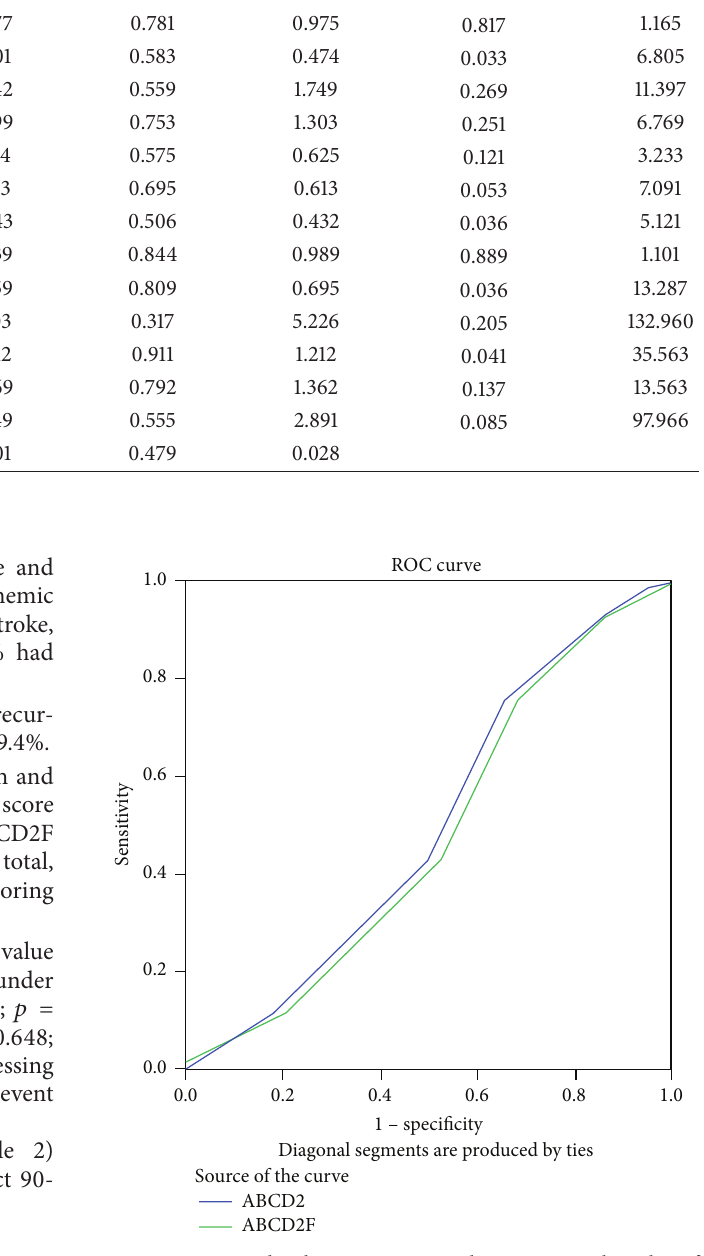
Figure 1: Area under the ROC curve analysis to assess the value of ABCD2 and ABCD2F tools to predict recurrent brain